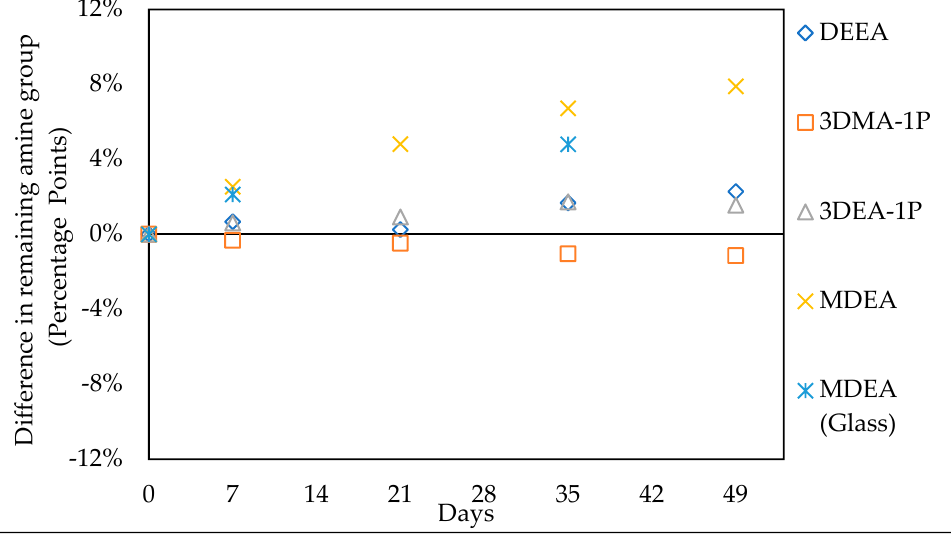
Figure 7. Di ff erence between the remaining amine group (percentage points) of aqueous amine solutions vs. the amine–MEG blend; unloaded amine wt.% = 30; CO 2 loading ≈ 0.1.